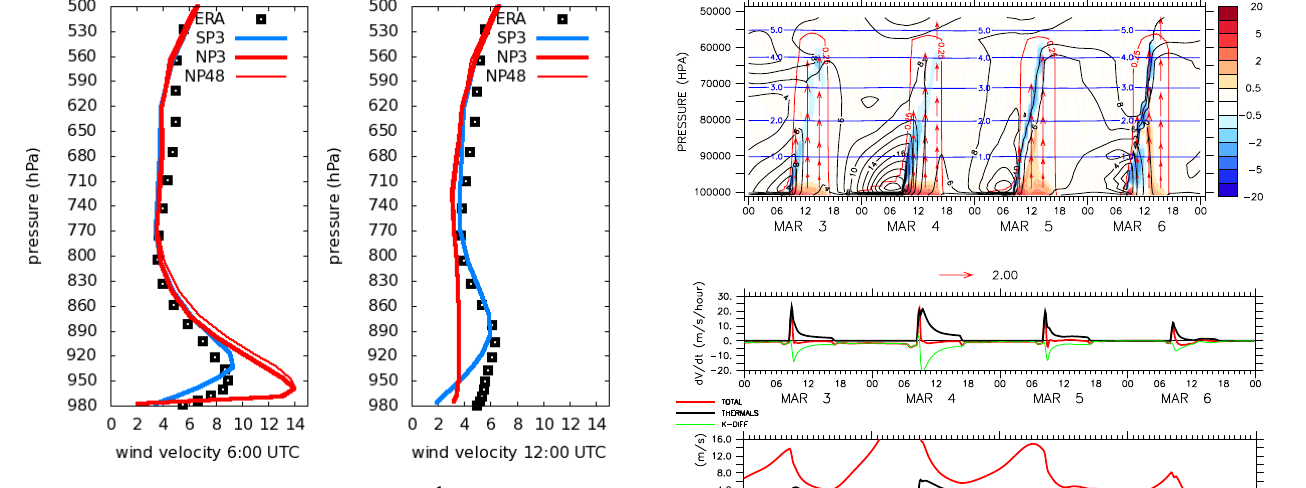
Figure 8. Wind mean vertical profiles (ms − 1 ) for JFM 2006 at 06:00 and 12:00UTC at Banizoumbou. Model results (colored curves) are compared to ERAI (black squares) for the same time period.